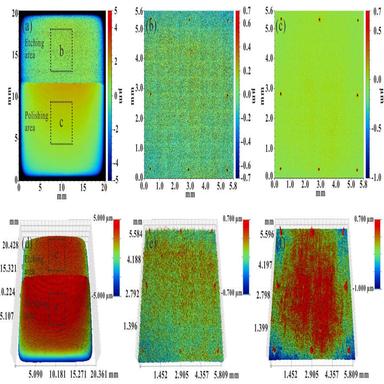
Surface profile of TC4 titanium alloy: (a) 2D contour map of surface profile, with corresponding 3D surface profile morphology as (d); (b) magnification of local micro-region of (a), with corresponding 3D surface profile morphology as (e); (c) magnification of local micro-region of (a), with corresponding 3D surface profile morphology as (f).